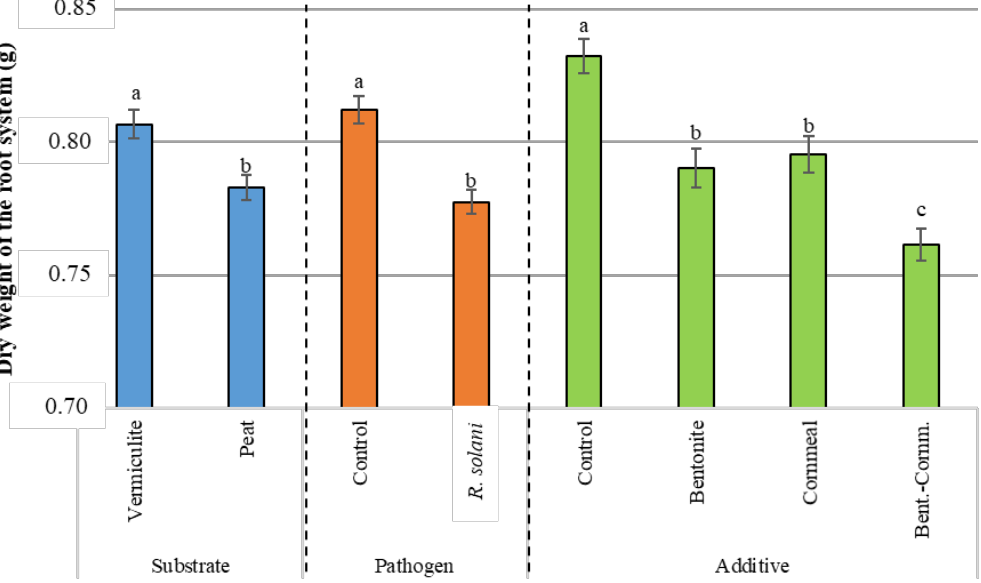
Figure 4. Dry weight of the bean root system for substrates, pathogen and additives. Blue colour represents the substrates; orange colour represents the presence or absence of R. solani ; green colour represents the types of additives. Bars of the same colour followed by di ff erent letters are significantly di ff erent ( p ≤ 0.01).